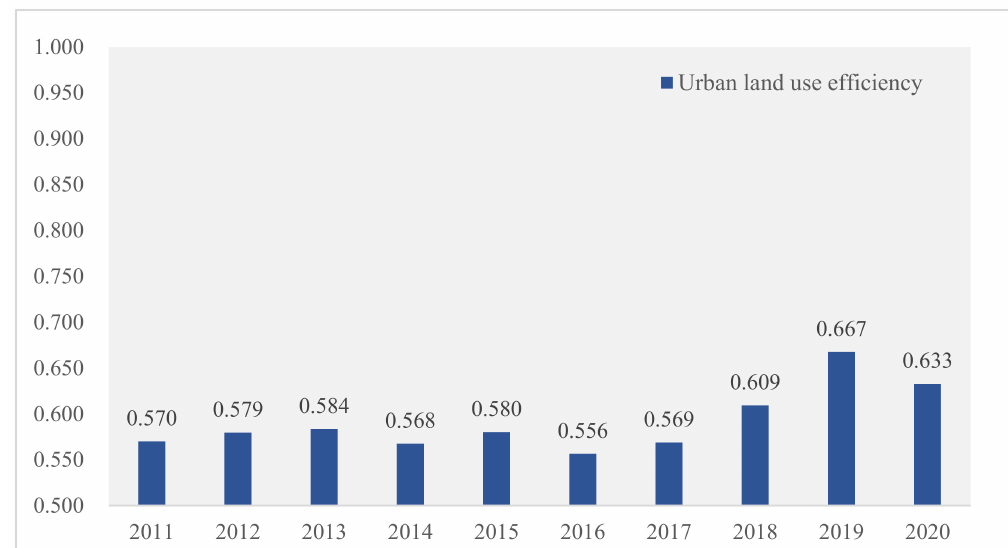
Figure 4. Evolution trend of the ULUE from 2011 to 2020. Source: Authors’